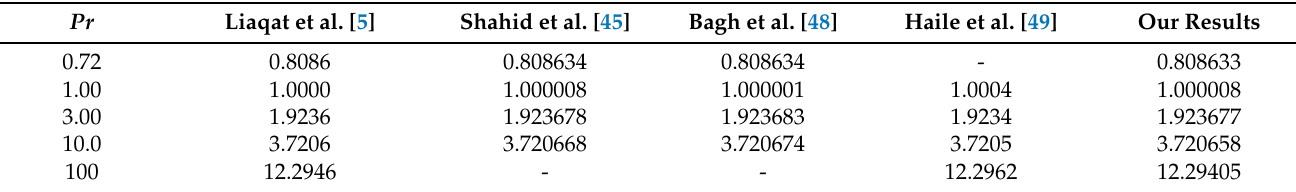
Table 3. Nusselt number comparison for various values of Prandtl